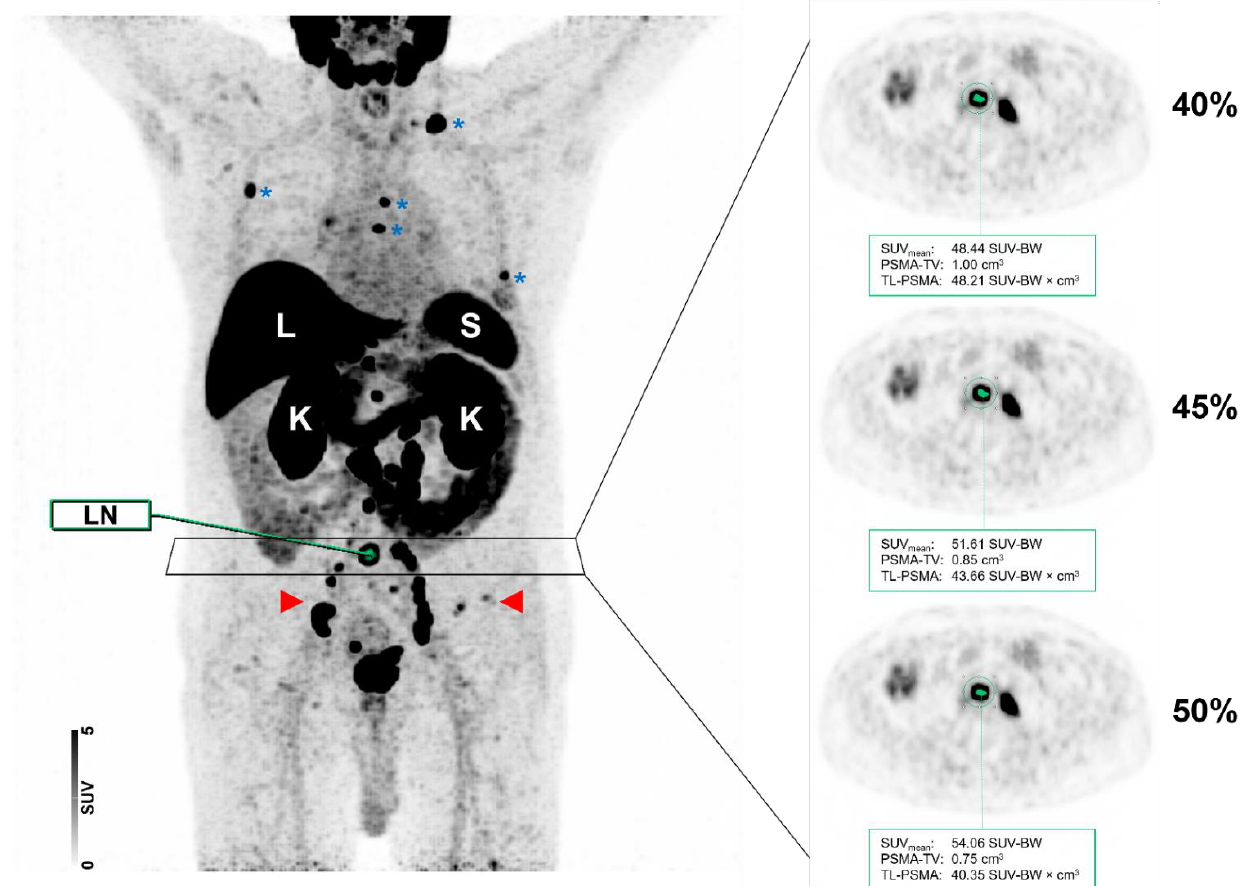
Figure 6. Maximum intensity projection (MIP) and axial positron emission tomography (PET) images of the same patient with different intensity thresholds (40 vs. 45 vs. 50%). Normal organ uptake in the liver (L), spleen (S), and kidneys (K) are indicated. The patient showed a relatively high tumor burden with multiple metastases involving both lymph nodes (red arrows) and the skeleton (blue asterisks). As shown for a PSMA-RADS-5 classified common iliac lymph node (LN), the segmentation did not differ visually when different maximum intensity thresholds of 40, 45, or 50% were applied.